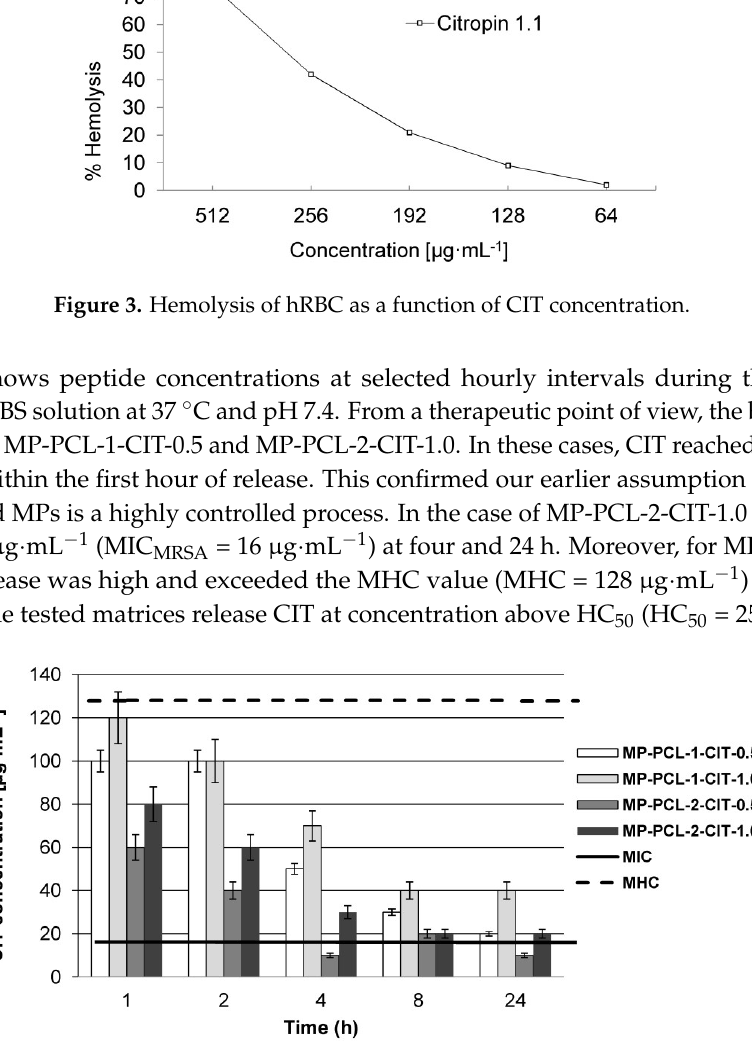
Figure 4. Peptide concentrations at selected hourly intervals during first 24 h of incubation in PBS solution at 37 °C and pH 7.4.